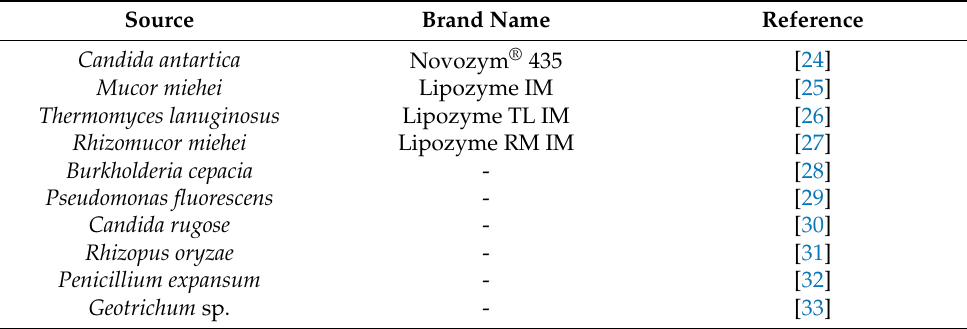
Table 1. Sources of lipase used in biodiesel